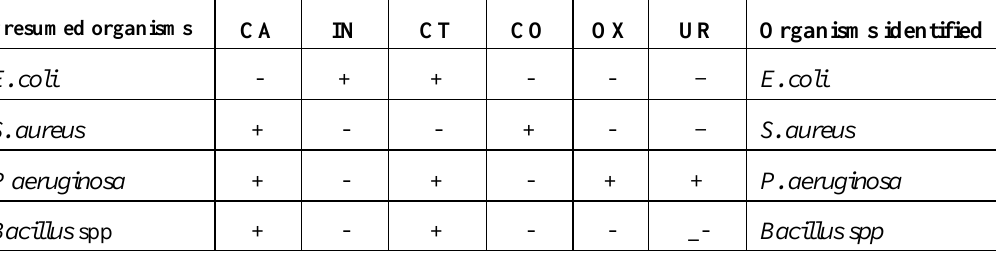
Table 3. Biochemical reactions of presumed isolates